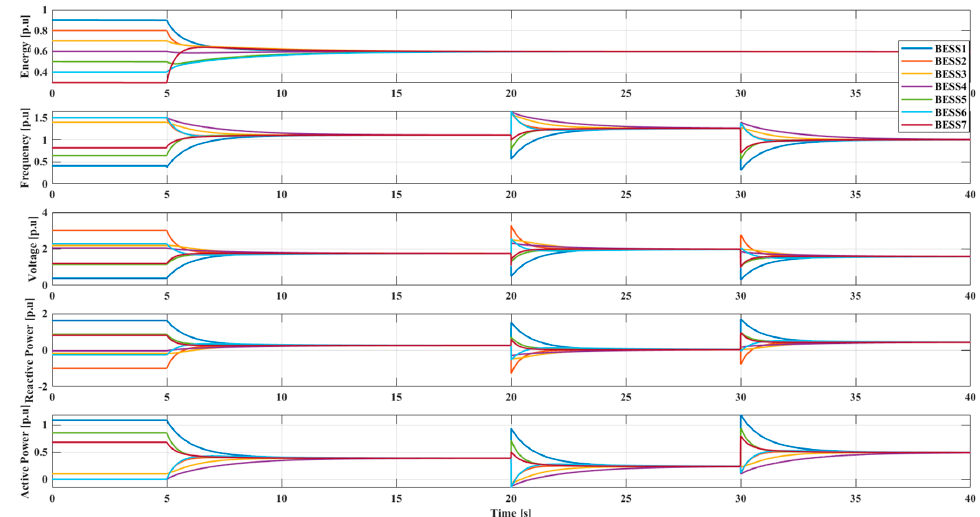
Figure 6. Simulation result without leader considering geographic factor (case 2).